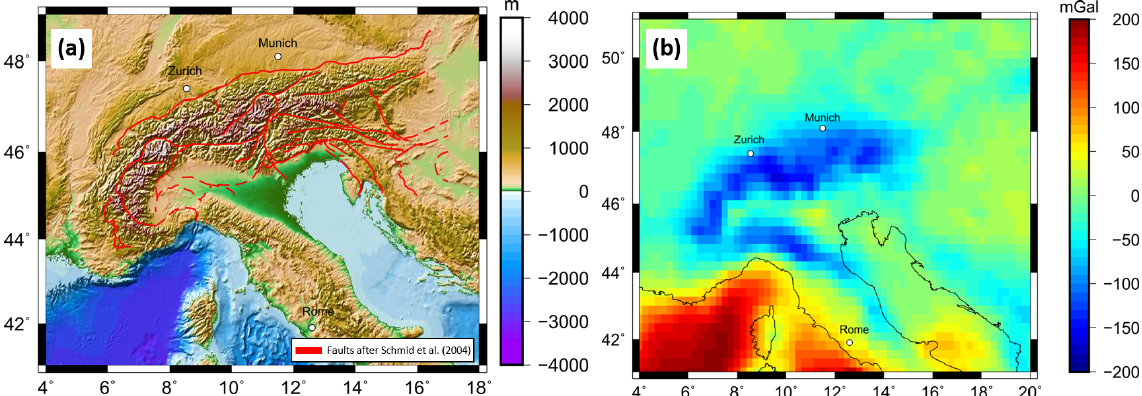
Figure 1. (a) Topography from ETOPO1 from Amante and Eakins (2009), with faults in red after Schmid et al. (2004). (b) Bouguer anomaly based on XGM 2019 (Zingerle et al., 2020) with a maximum spherical harmonics degree of 719 at a station height of 6040m above the ellipsoid, just above the surface of the Alps. Correction density for rock: 2670kgm − 3 ; and for water: 1030kgm − 3